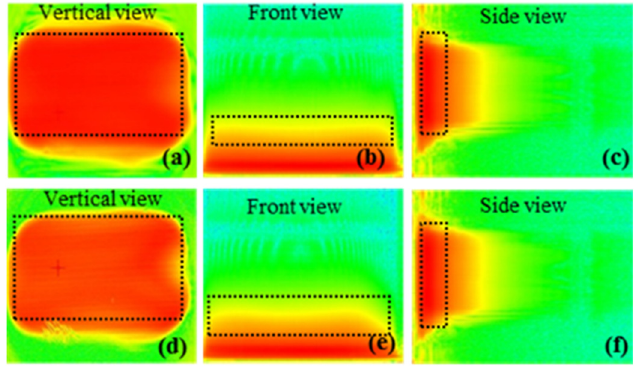
Figure 22. Frequency-domain imaging for artificial test samples [73]. ( a – c ) Three-view imaging results at 0.623 THz; ( d – f ) Three-view imaging results at 1.648 THz.